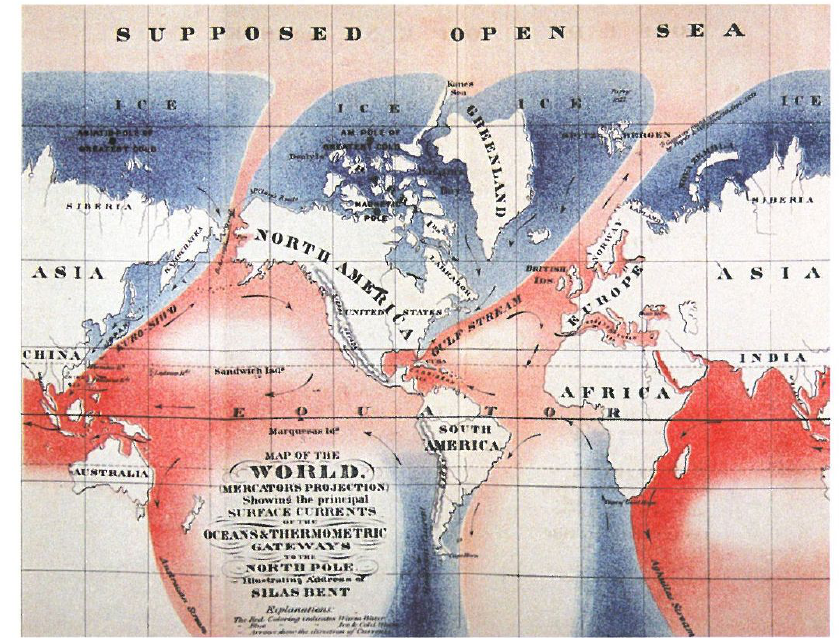
Fig. 1. A map by Silas Bent, 1872, showing the warm ocean currents and their assumed impact on the ice cover of the Arctic Ocean. From Hayes